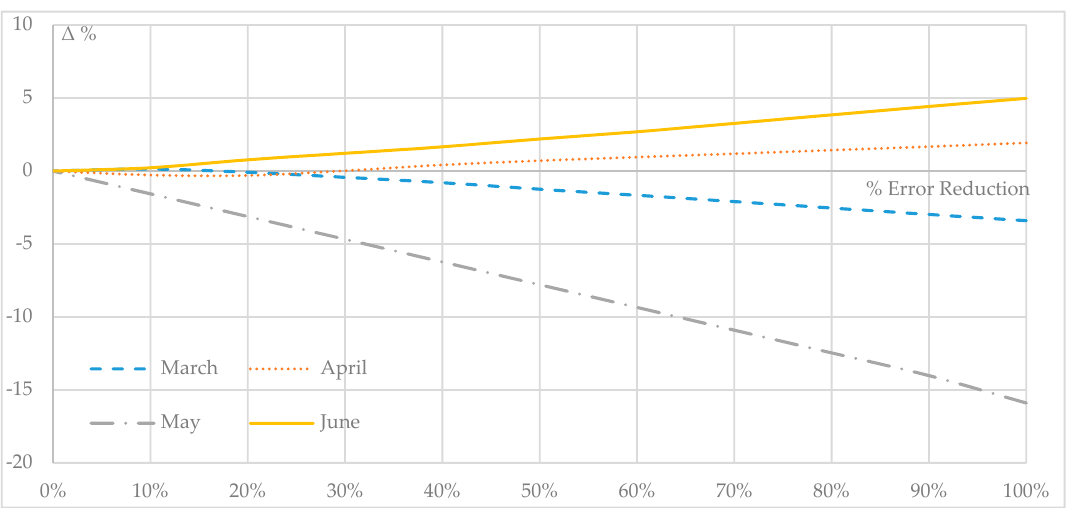
Figure 10. Economic evaluation: losses trend with forecast error reduction.